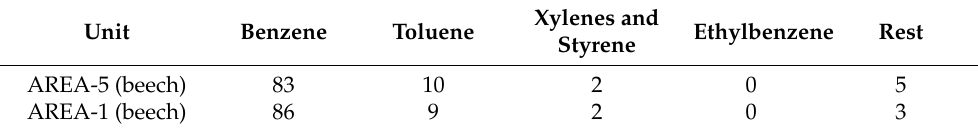
Table 9. Composition of the collected BTX sample from beechwood gasification using AREA (wt%).